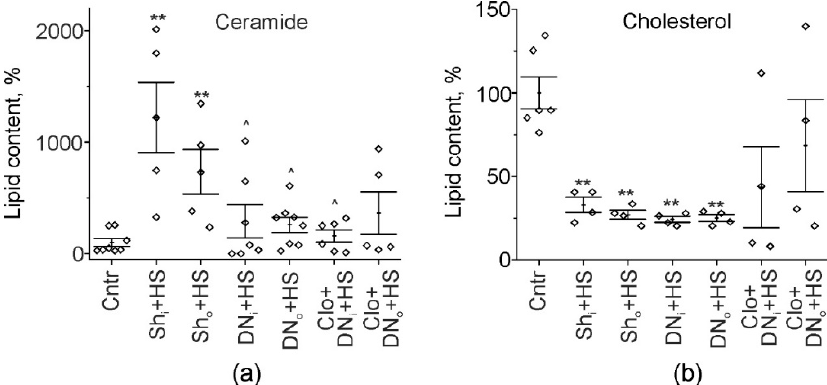
Figure 3. Cer and Chol amount in soleus muscle homogenates. ( a,b ) Quantifications of Cer and Chol content (in %). Shown data for control (Cntr), sham-operated suspended (Sh+HS), unilaterally denervated suspended (DN+HS) and clomipramine-pretreated unilaterally denervated suspended (Clo+DN+HS) rats. Sh i and Sh o —muscles from the intact and sham-operated limb; DN i and DN o —muscles from the intact and denervated limb. Data are represented as mean ± SEM; diamonds are individual values; N = 5–8 per group. ** p < 0.01, —differences compared to control (Cntr); ^ p < 0.05—differences compared to HS sham operated animals. p was evaluated by Kruskal–Wallis and Mann–Whitney tests.